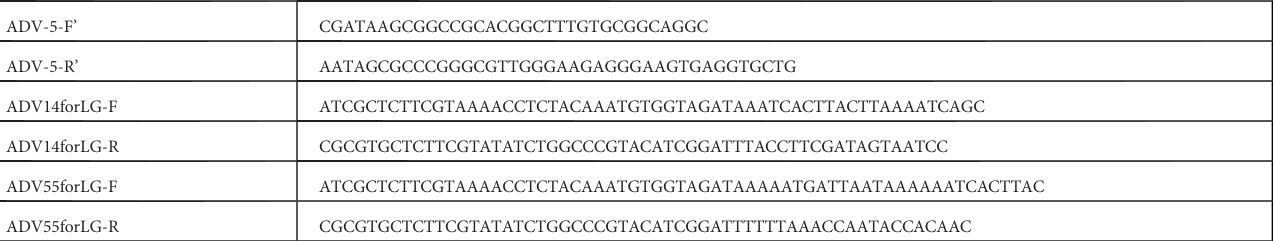
TABLE 2 Primers for cloning fragment 5 into the pBR322 vector and replacement of the E3 region with the luciferase and GFP expressing